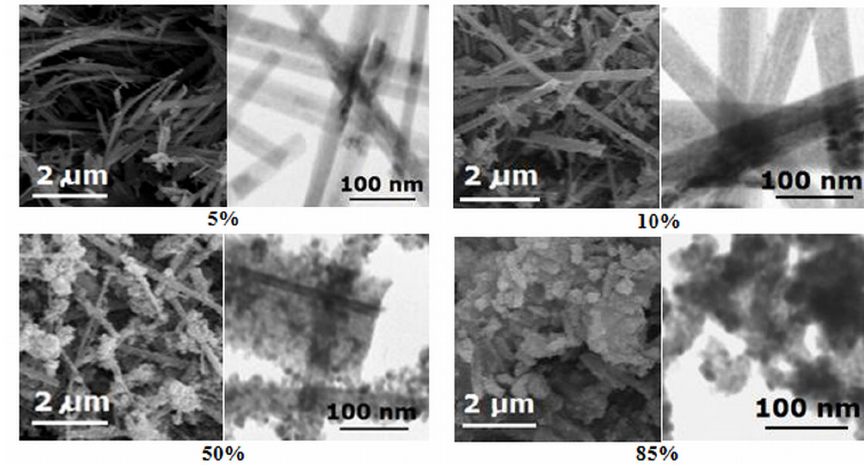
Figure 9: SEM (left) and TEM (right) of samples prepared with varied autoclave filling fraction.